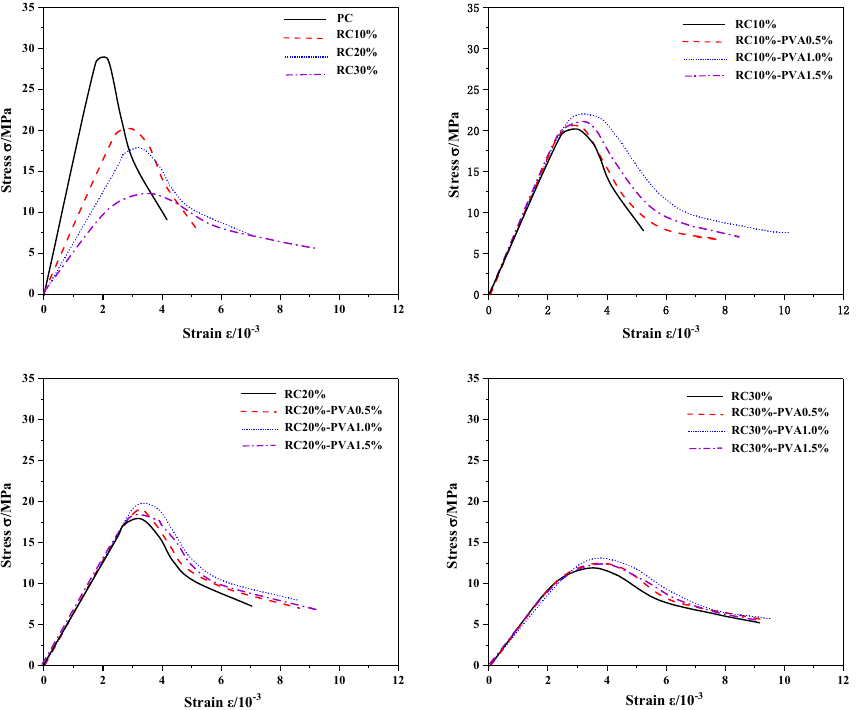
Figure 8. Full stress–strain curve of PVA rubber/concrete specimen under uniaxial compression.